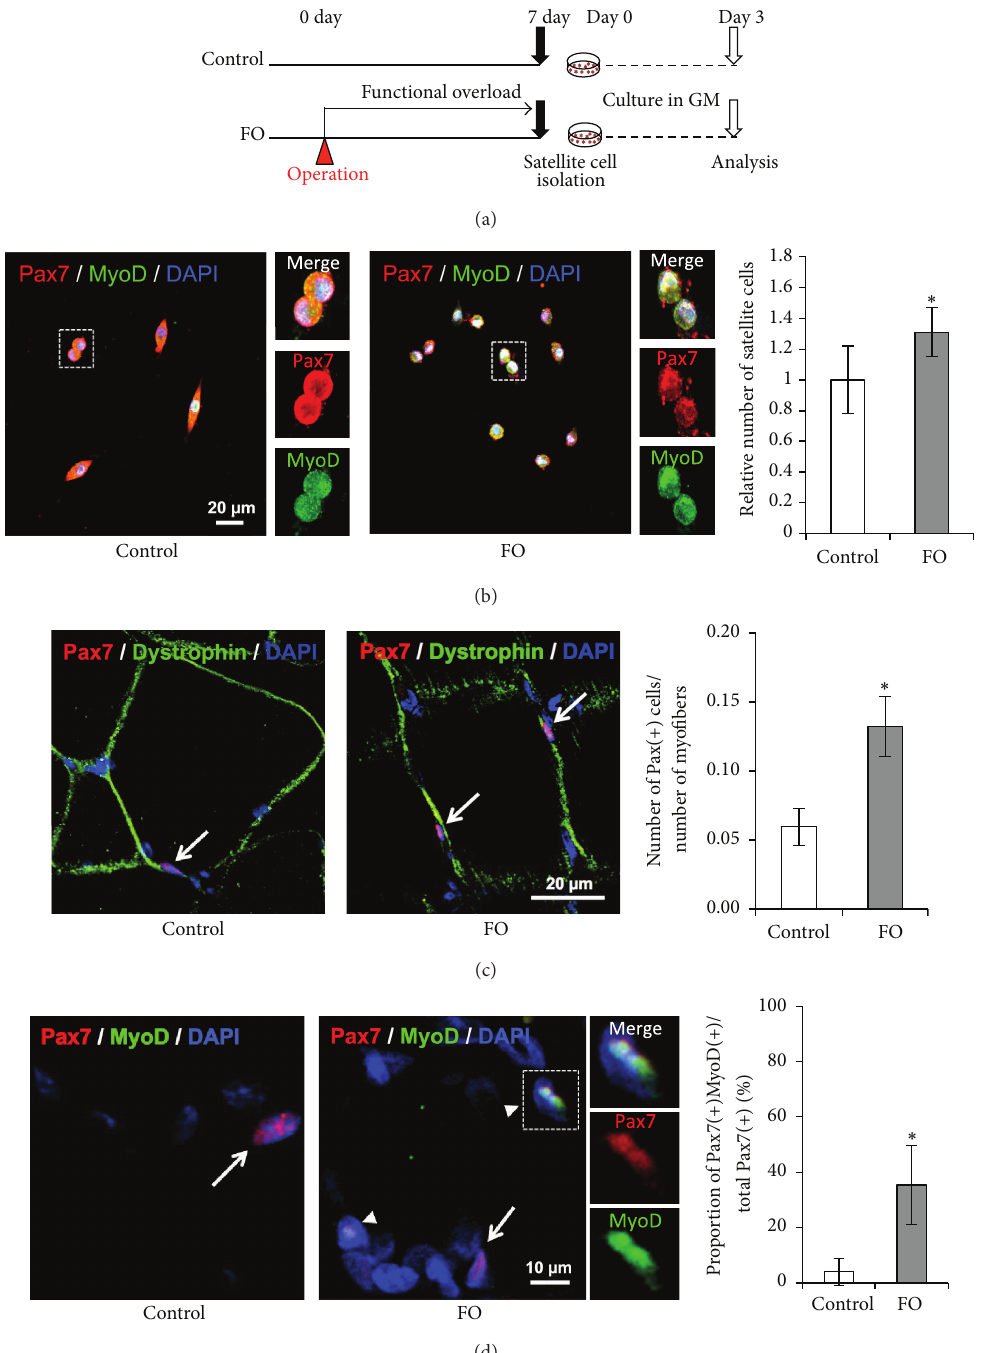
Figure 2: Satellite cell activation and proliferation following functional overload. (a) Schematic representation of the experimental design. FO group rats had a surgical operation to ablate synergistic muscles and received functional overload stimulation for 1 week. Satellite cells were isolated from plantaris of each group of rats 7 days after operation and were cultured in growth medium for 3 days. (b) Immunocytochemistry analysis of cultivated-satellite cells. Representative merged images of immunocytochemistry staining for Pax7 (red) and MyoD (green) with DAPI from control group (left panel) and FO group (right panel) are shown. Magnification of the area surrounded by the dotted square is shown in the right panels. Relative number, normalized to the number observed for the control group, of Pax7(+)MyoD(+) cells is shown in the right graph. (c, d) Immunohistochemistry analysis of satellite cells following functional overload. Representative merged images of immunohistochemistry staining for Pax7 (red) and Dystrophin (green) (c) or for Pax7 (red) and MyoD (green) (d) with DAPI from control group (left panel) and FO group (right panel) are shown. Magnification of the area surrounded by the dotted square is shown in the right panels. The proportion of Pax7(+) cells per myofibers (c) or the proportion of Pax7(+)MyoD(+) cells per total Pax7(+) cells (d) is shown in the right graphs. White arrows and arrowheads indicate Pax7(+) cells and Pax7(+)MyoD(+) cells, respectively. All values are expressed as mean ± SDM (𝑛 = 5) . Significant differences: ∗ compared to control group (𝑃 < 0.05)